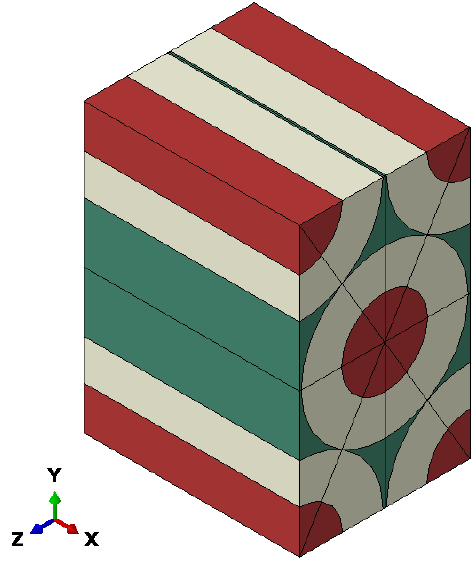
Figure 7. Representative volume element (RVE) selected for the actual coil